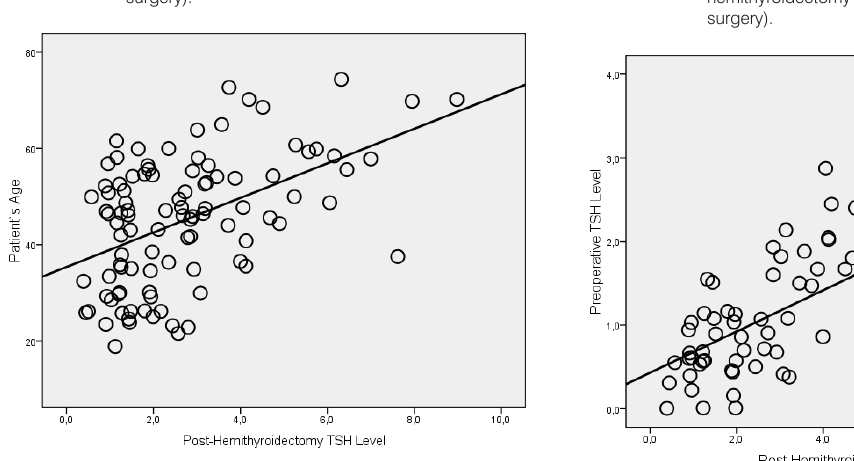
Figure 1a. Scatter diagram of the patient’s age (years) versus the post-hemithyroidectomy TSH level (2 months after the surgery).